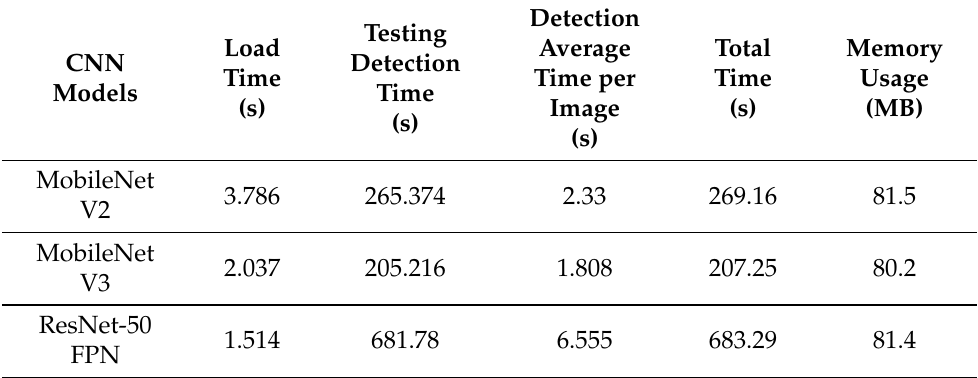
Table 3. Experimental Scenario I; cloud server version I (octa-core system) detection time and memory usage.